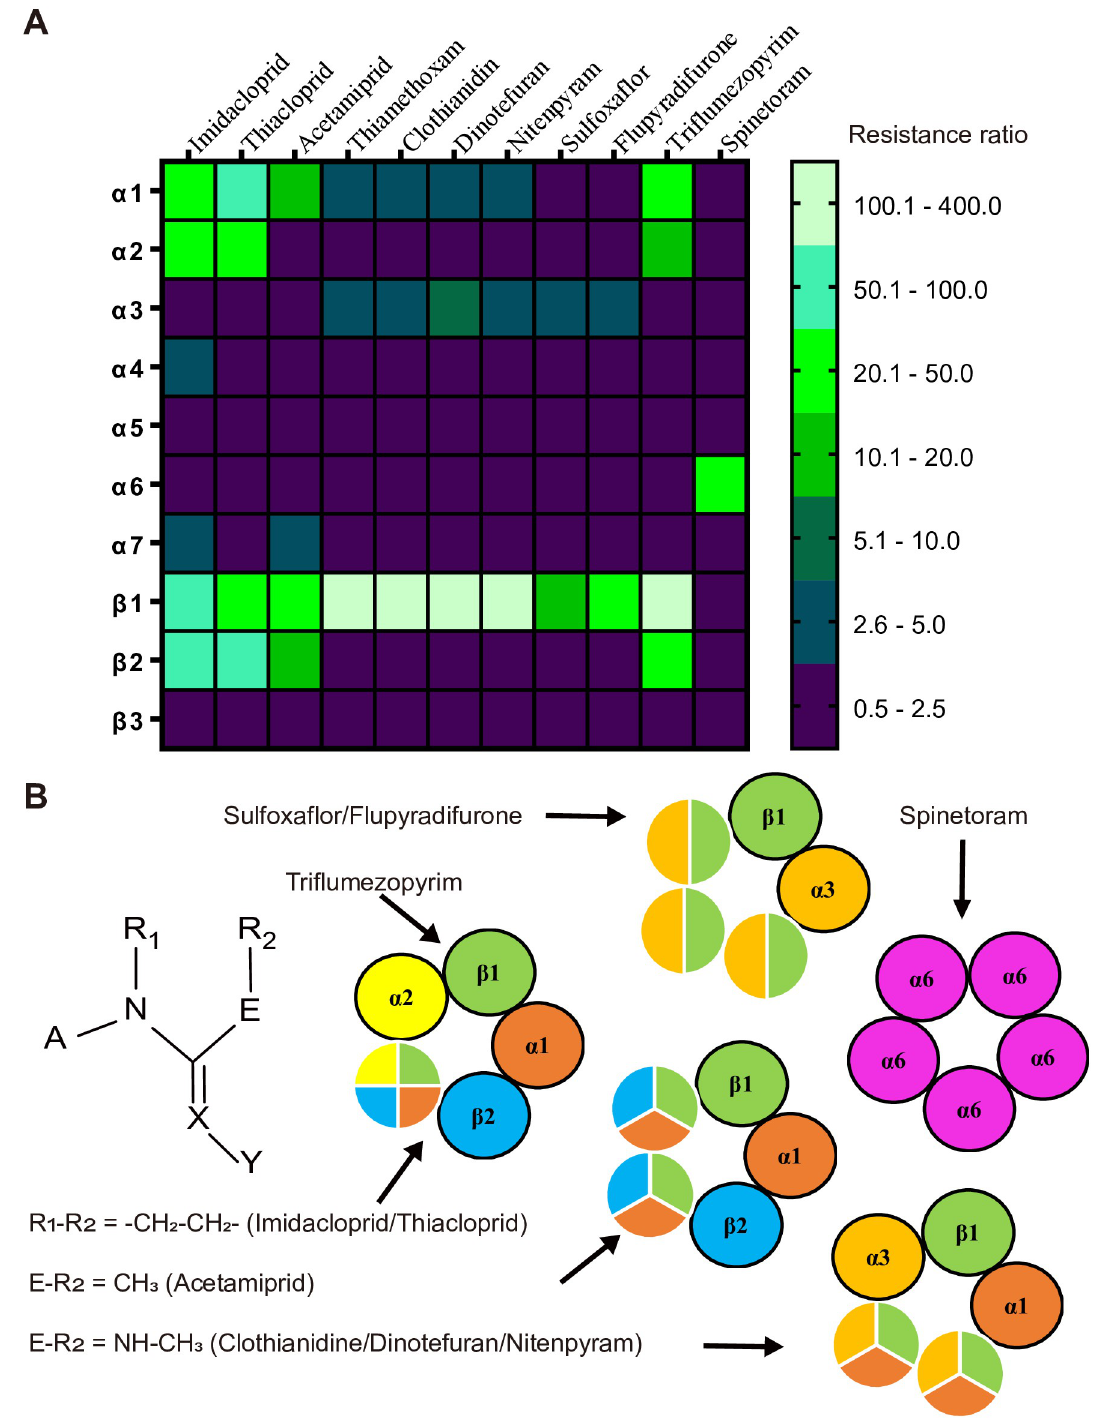
Fig 4. Resistance patterns of the tested insecticides on different nAChR mutants (A) and proposed target receptor subtypes for neonicotinoids and others (B). Various resistance ratios are grouped and represented as different colors in the heatmap. Thiamethoxam is considered a prodrug of clothianidin and thus is not listed in the structural formula.